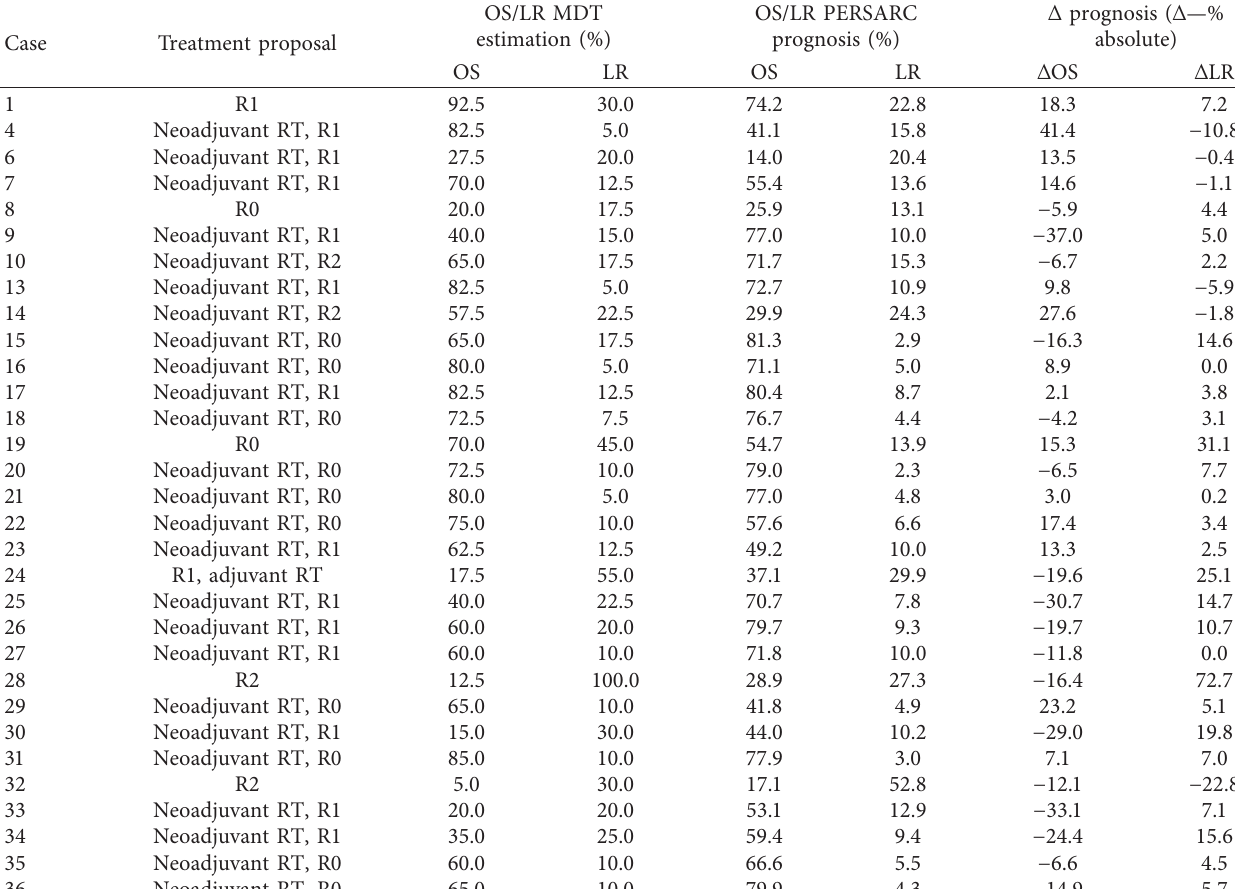
Table 3: Estimated and calculated OS and LR for each case with and without